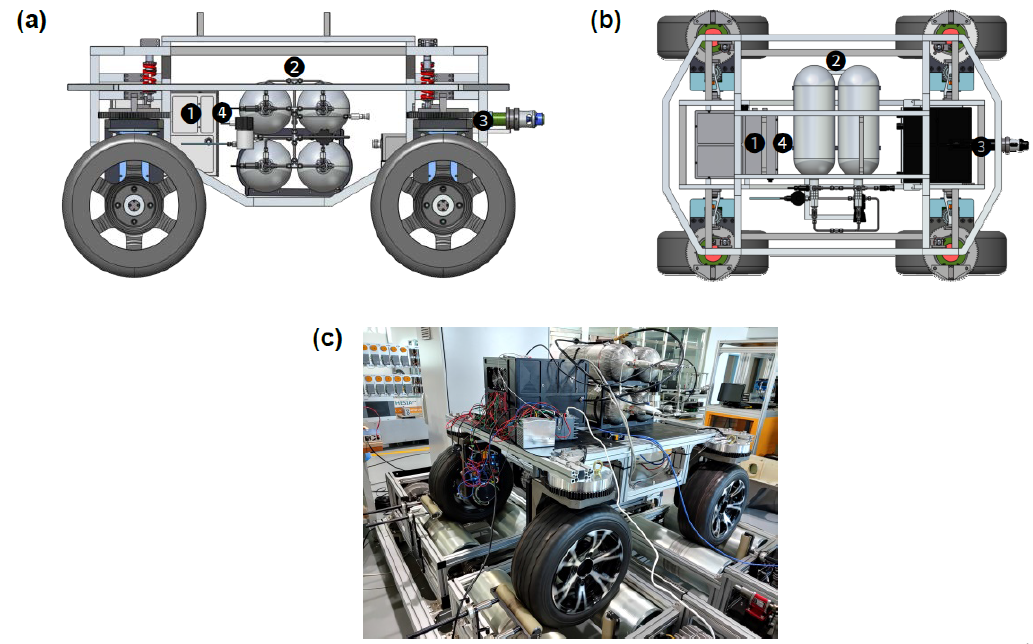
Figure 4. Design drawing of the integrated plug-in HPS. ( a ) Side view and ( b ) Top view showing (1) fuel cell, (2) fuel storage, (3) battery, and (4) DC/DC converter. ( c ) Pre-prototype under integration tests.